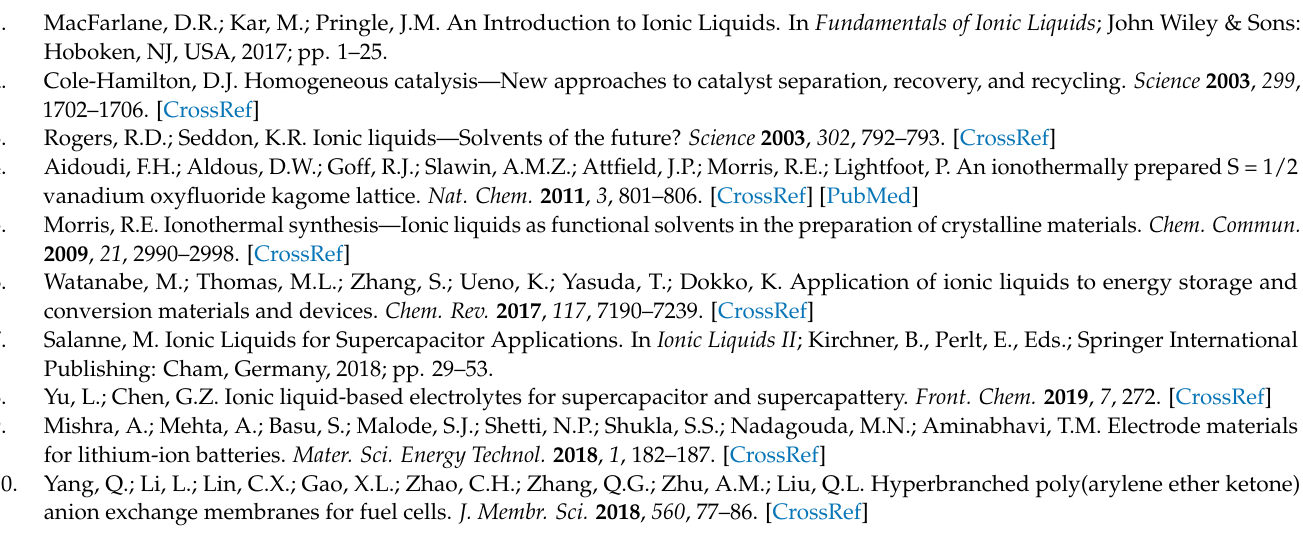
Figure S3: 1 H NMR for (BMIM)(HQS), Figure S4: 13 C NMR for (BMIM)(HQS), Figure S5: CV of the pure (BMIM)(HQS) over the temperature range RT—70 ◦ C. The scan rate is 10 mV/s, the working electrode is a 300 µ m thickness JNTG carbon paper, Figure S6: MS spectrum of (BMIM)(Cl) in positive mode, Figure S7: MS spectrum of (BMIM)(HQS) in positive mode, Figure S8: MS spectrum of (BMIM)(HQS) in negative